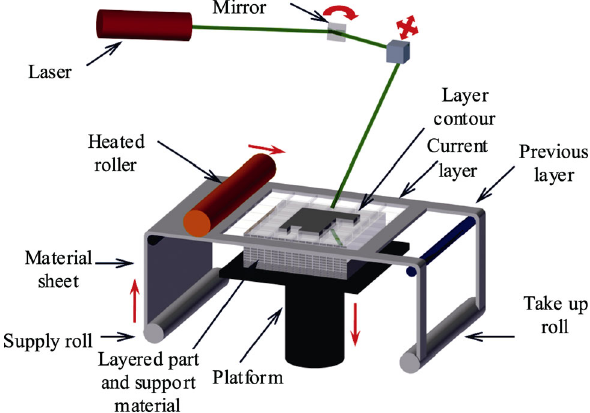
Fig. 13 Sheet lamination process.